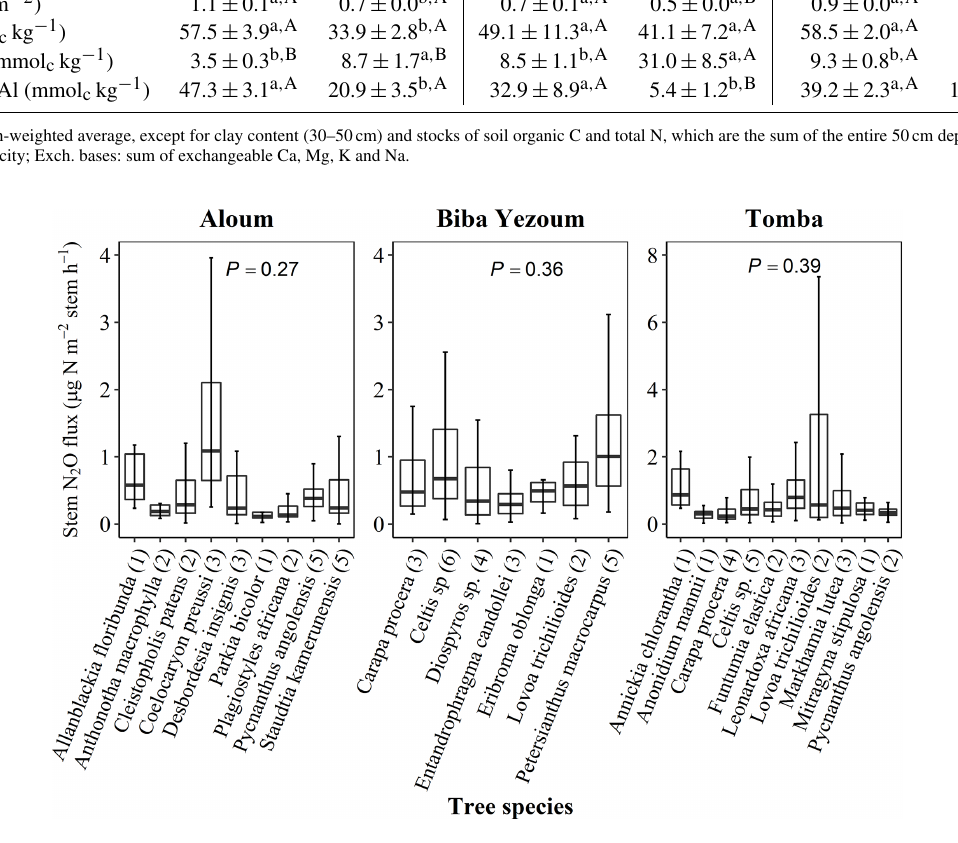
Figure 1. Stem N 2 O fluxes from 22 tree species at three forest sites (Aloum, Biba Yezoum and Tomba) across central and south Cameroon in the Congo Basin. Boxes (25th, median and 75th percentile) and whiskers (1 . 5 × interquartile range) are based on N 2 O fluxes measured monthly from May 2017 to April 2018 for each tree species, and the values in parentheses represent the number of trees measured per species. There were no differences in N 2 O fluxes among species (linear mixed-effect models with Tukey’s HSD at P ≥ 0 .